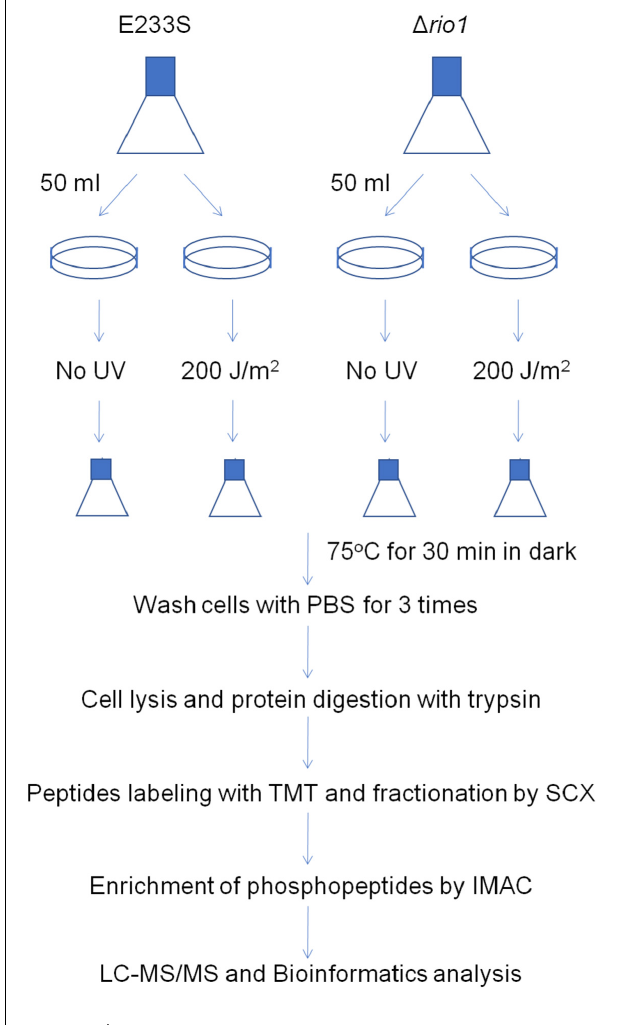
FIGURE 2 | Schematic of sample preparation for phosphoproteomics analysis. A volume of 250 mL of E233S and (cid:49) rio1 strain was cultivated to OD 600 ∼ 0.28. Aliquots of 50 mL were transferred to petri dishes (15 cm in diameter), which were subsequently put in a CL-1000 Ultraviolet crosslinker. Cells were irradiated with 200 J/m 2 UV or mock-treated and transferred back to a culture flask. The flasks were incubated at 75 ◦ C for 30 min in the dark. Cells were collected by centrifugation at 6,245 g for 10 min and washed with PBS buffer three times. The cell pellets were ground in liquid nitrogen, and total proteins were digested with trypsin. The peptides were labeled with TMT and fractionated by SCX. The phosphopeptides were enriched by IMAC and subjected to LC-MS/MS and bioinformatics analysis. Two repeats were used for each